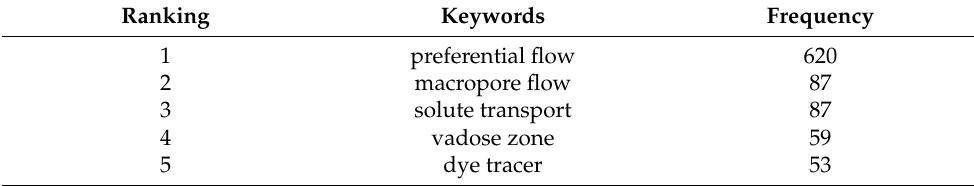
Table 1. Frequency of keywords from WoS database. Ranking